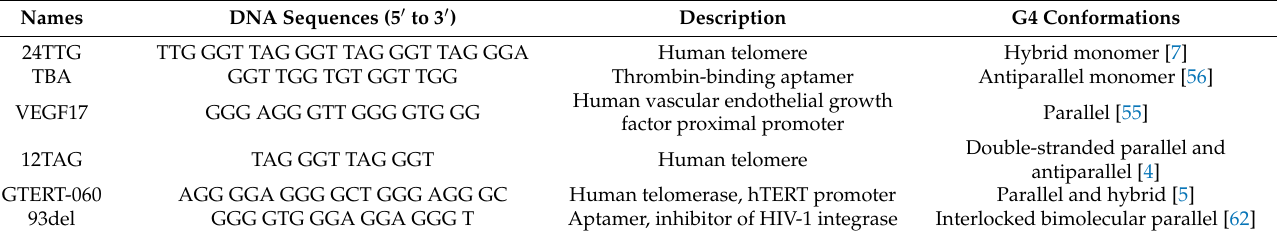
Table 2. DNA sequences utilized in this